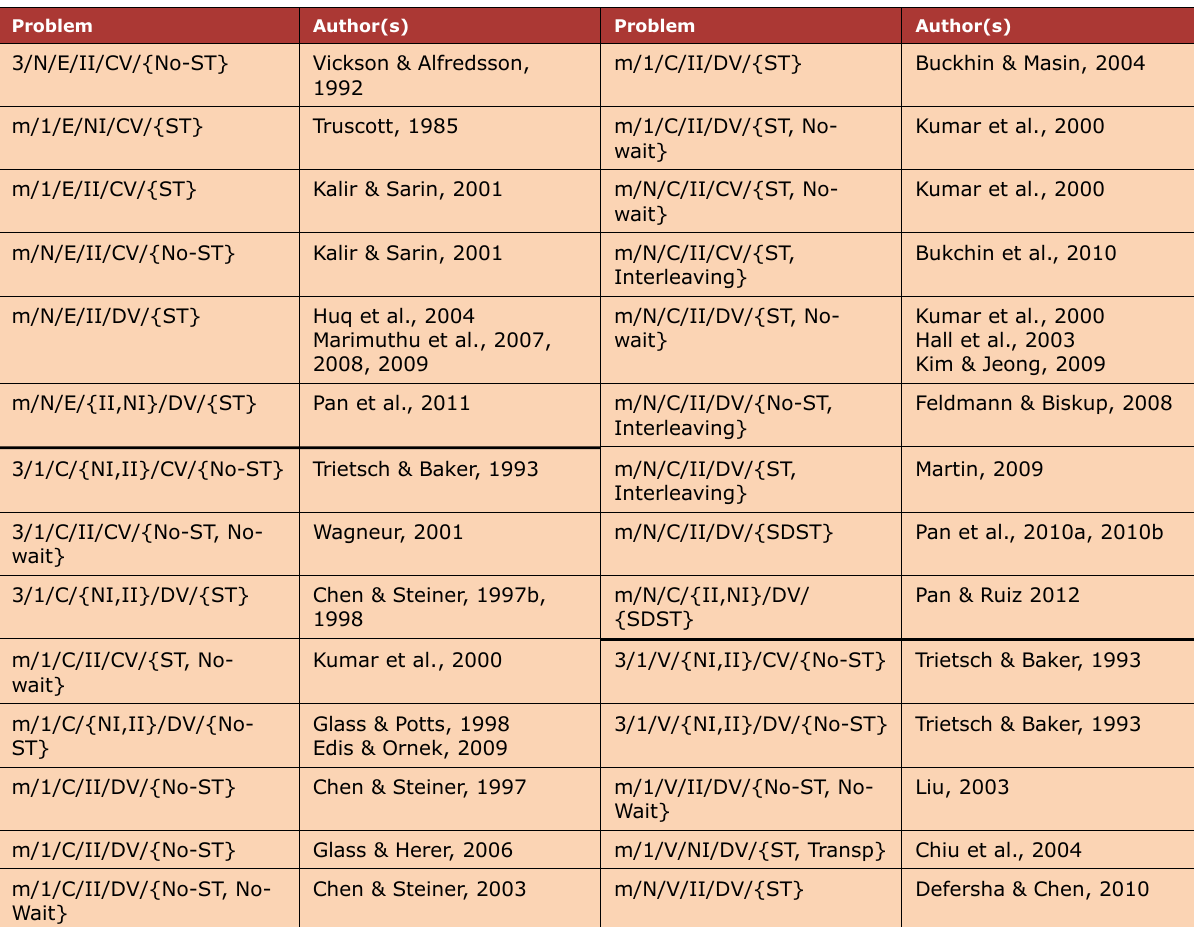
Table 2. Paper of more than 2-stage flow